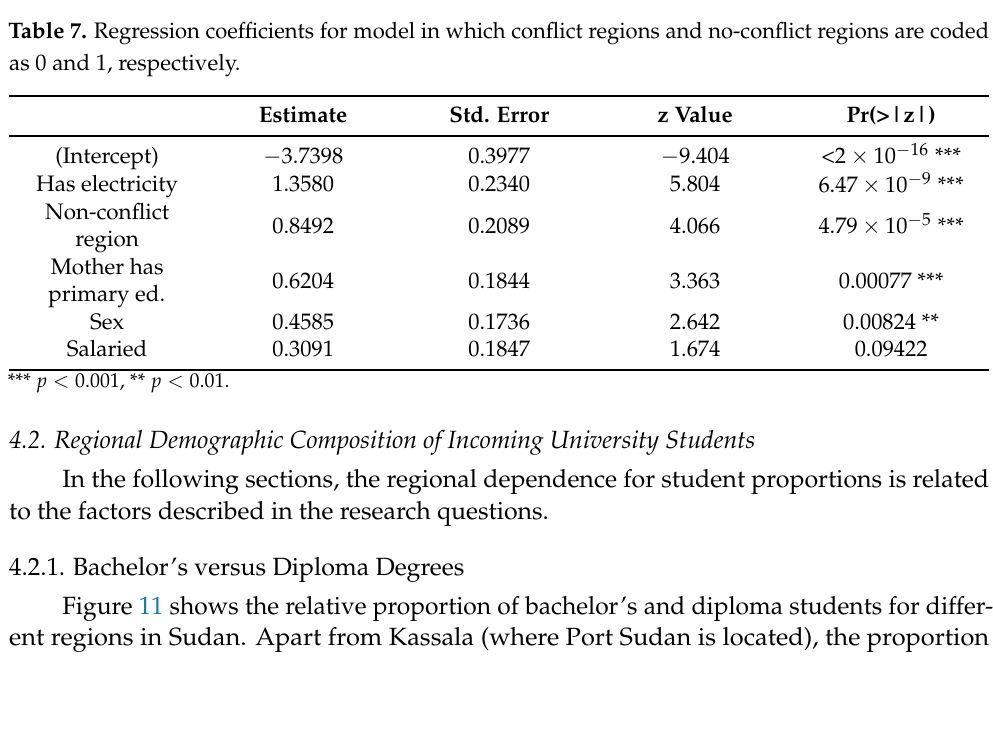
w/o Mother’s w/o Mother’s ed. & Full Model Primary ed.